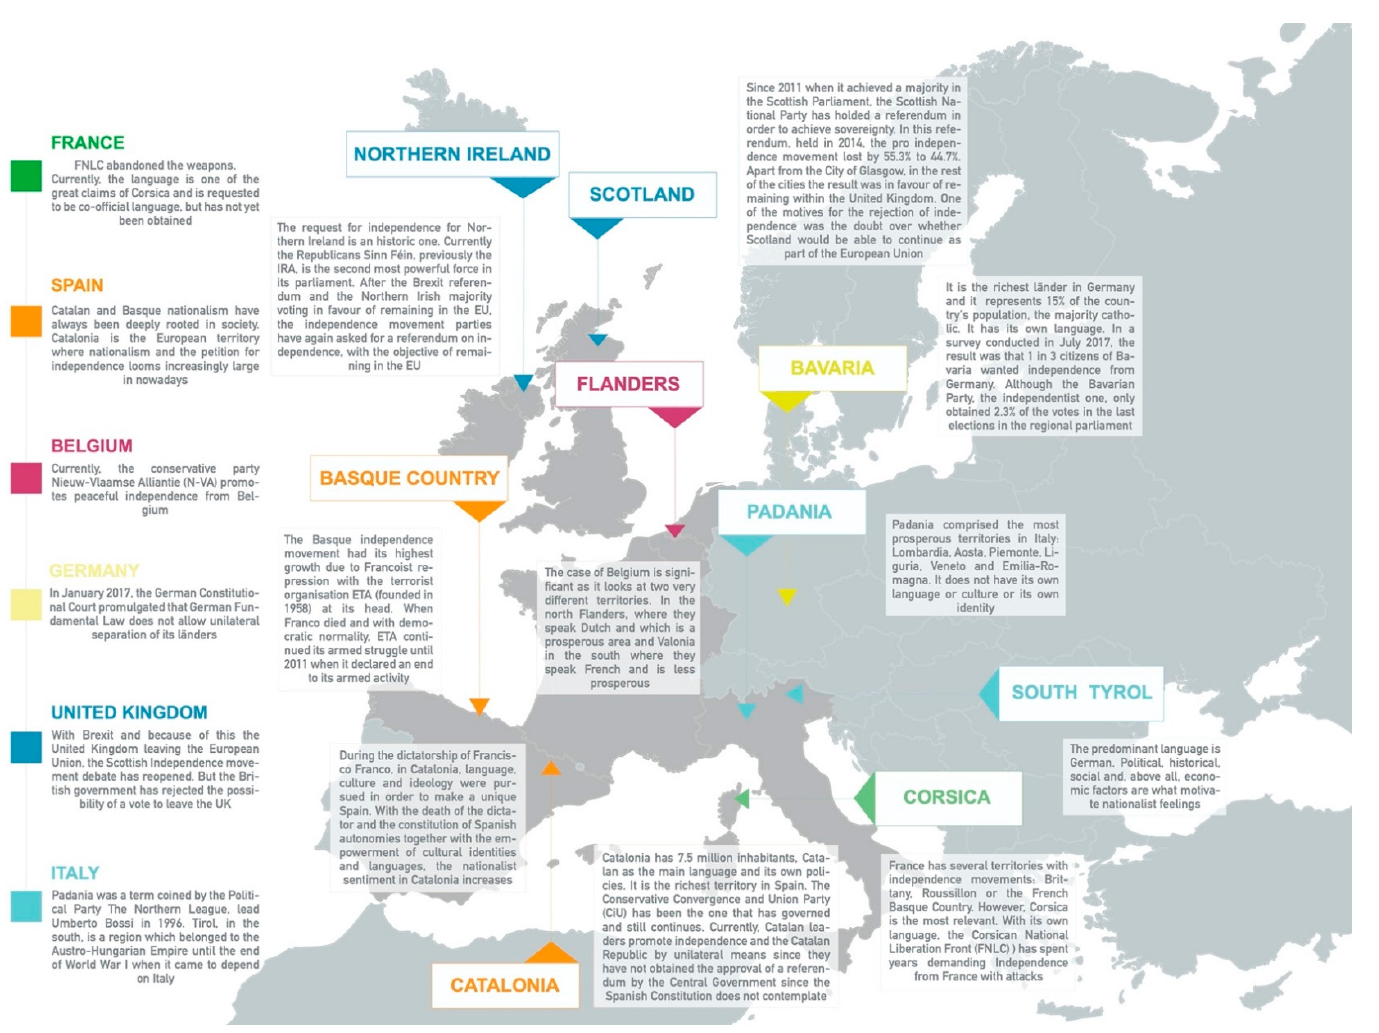
Figure 1. Independence movements in Europe.